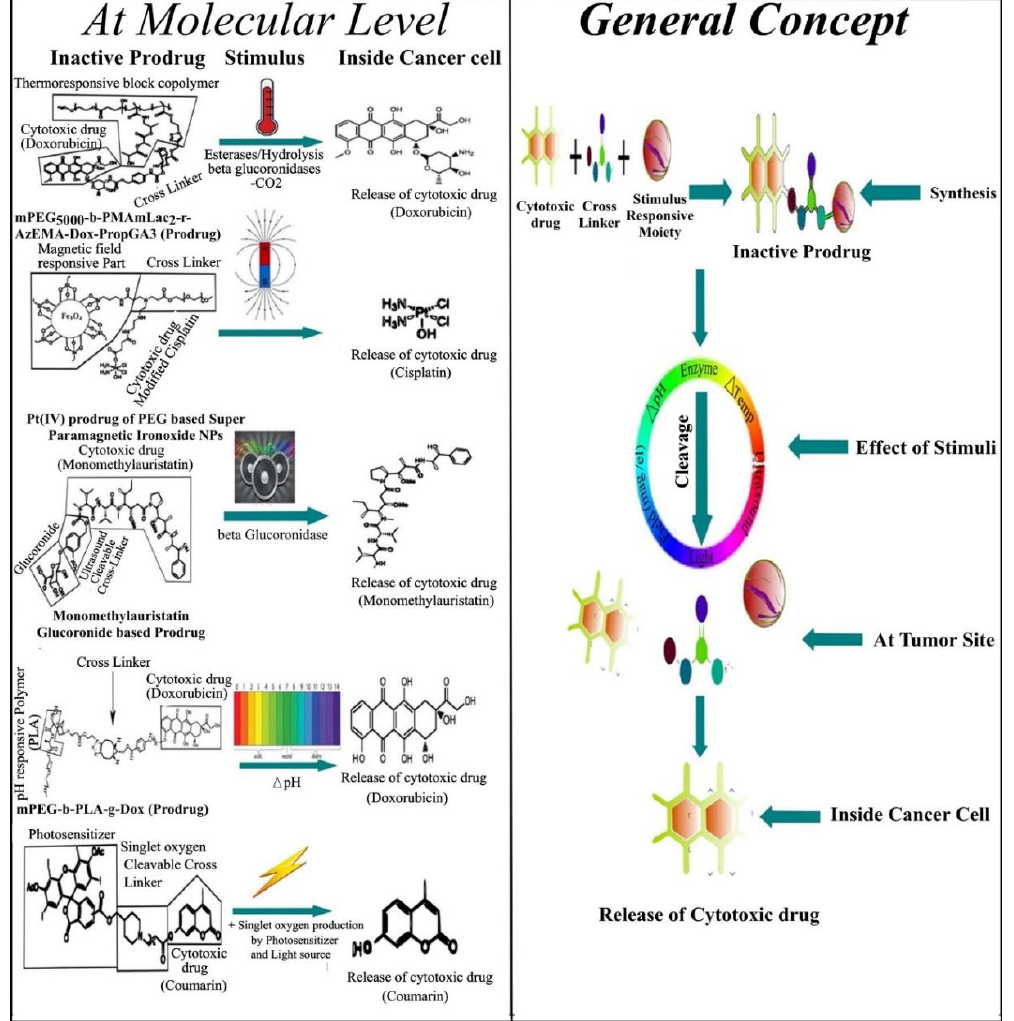
Figure 5. Stimuli-Responsive Prodrugs for Cancer Chemotherapy. “mPEG 5000 -b-(HPMAmLac2-r-AzEMA)-DOX-PropGA3” represents poly(ethylene glycol) 5000 -b-poly[N-(2-hydroxypropyl) methacrylamide-lactate]2-2-azidoethyl methacrylate-doxorubicin propargyl glucuronide A3 prodrug, “mPEG-b-PLA-g-DOX” represents mPolyethyleneglycol-b-norbornene functionalized polylactic acid-grafted doxorubicin. Table 6. Stimuli-Responsive Prodrugs for Cancer Chemotherapy.